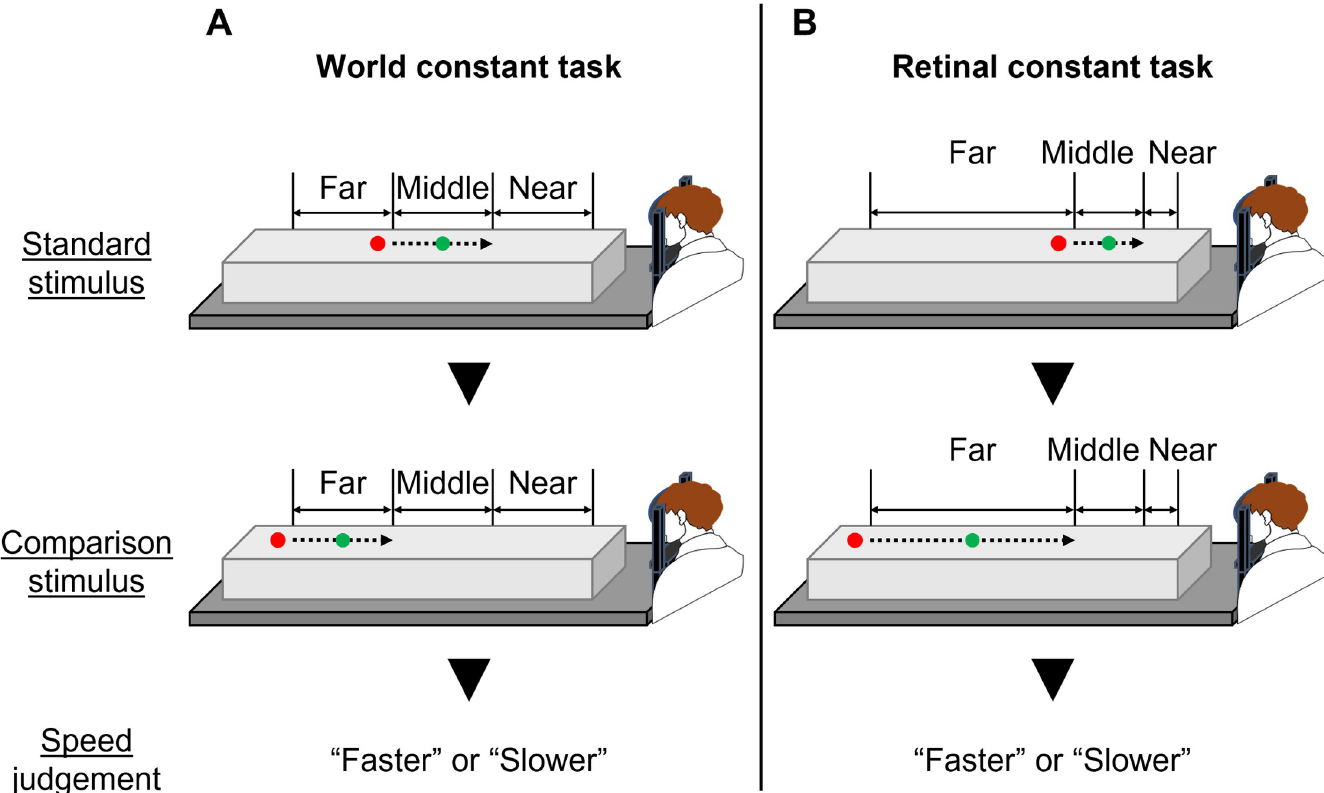
Fig 2. A two-alternative forced-choice paradigm. World constant task (A): the green circle (visual target) moved from far to near at constant velocity in the real world, while participants kept their eyes on the red circle (fixation point). Retinal constant task (B): visual target moved from far to near at constant velocity on the retina, while participants kept their eyes on the fixation point. In both speed perception tasks, participants compared the target speed between the standard and comparison stimuli.